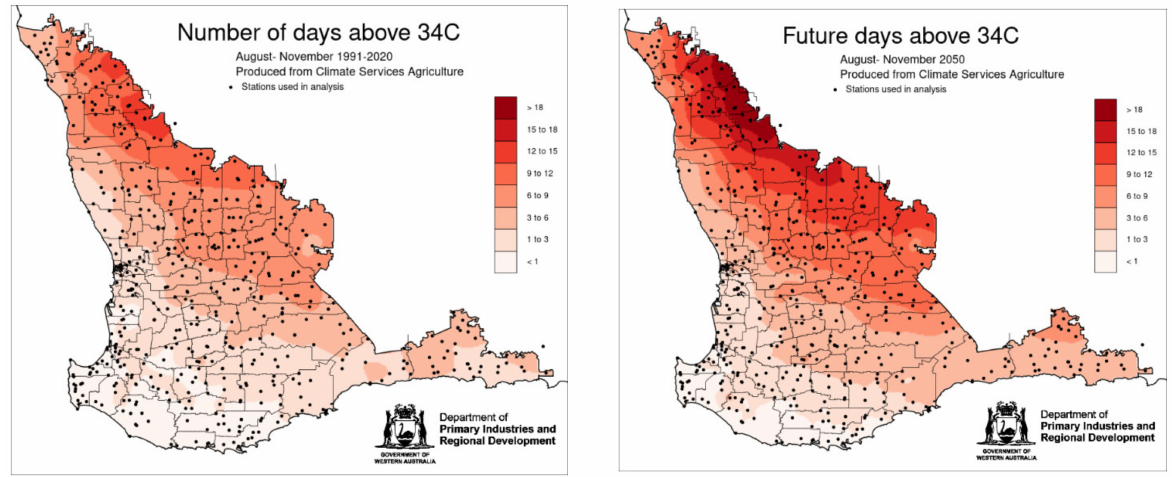
Figure 3. Climate maps for the study region. Source: DPIRD